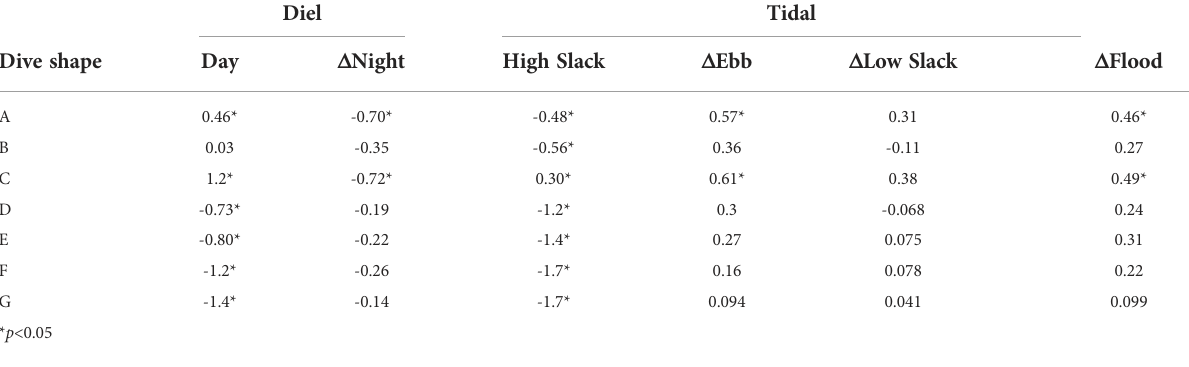
TABLE 3 Effect sizes for the Dirichlet regression of proportion of time basking sharks exhibited each subsurface movement shape (A-H) as a function of diel and tide time periods. Diel